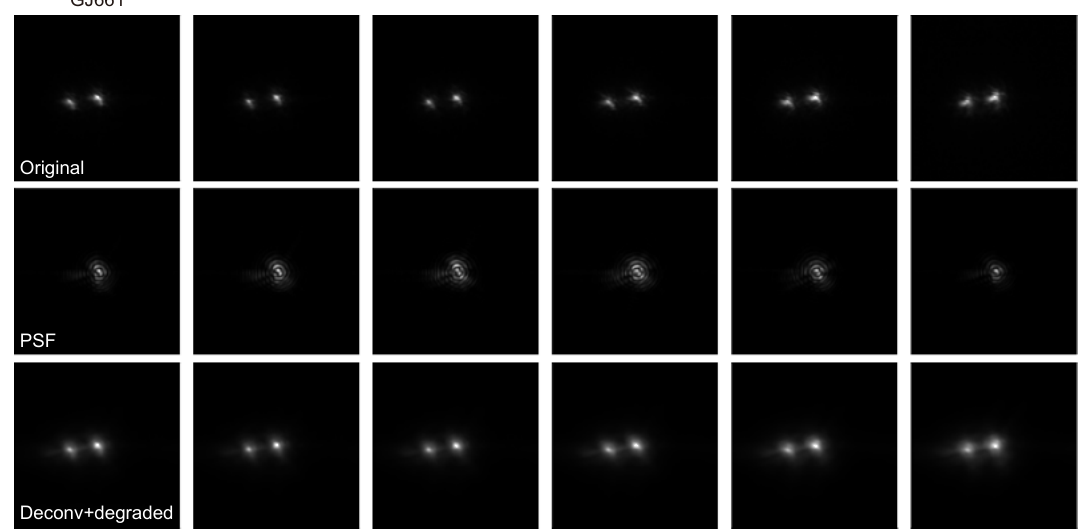
Fig. 21 | Original frames of the burst (upper row), estimated PSF (middle row) and for the GJ661. The upper row shows six raw frames of the burst. The second row displays the instantaneous PSF estimated by the neural network approach. The last row shows the results from re- convolve the deconvolved image with the estimated PSF. Figure reproduced from ref. 97 , arXiv.